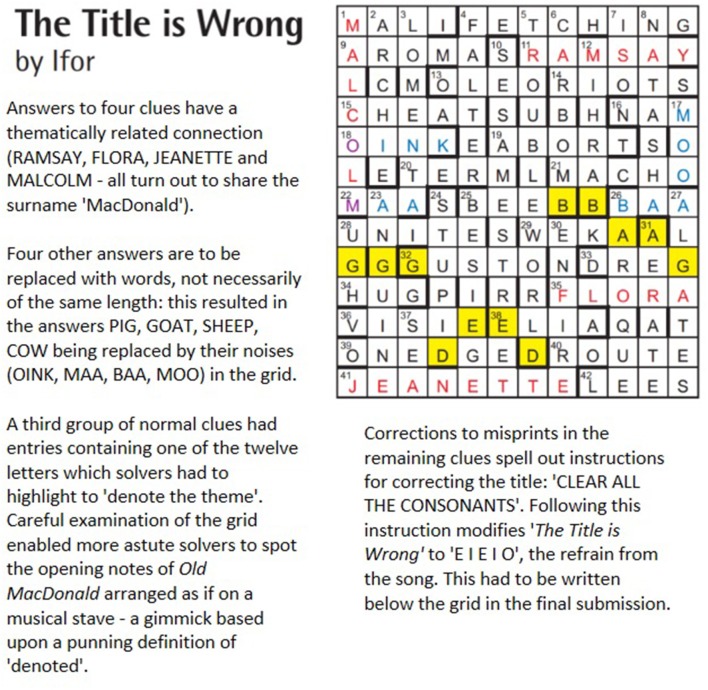
Magpie crossword issue 130.4 (Ifor, 2013).